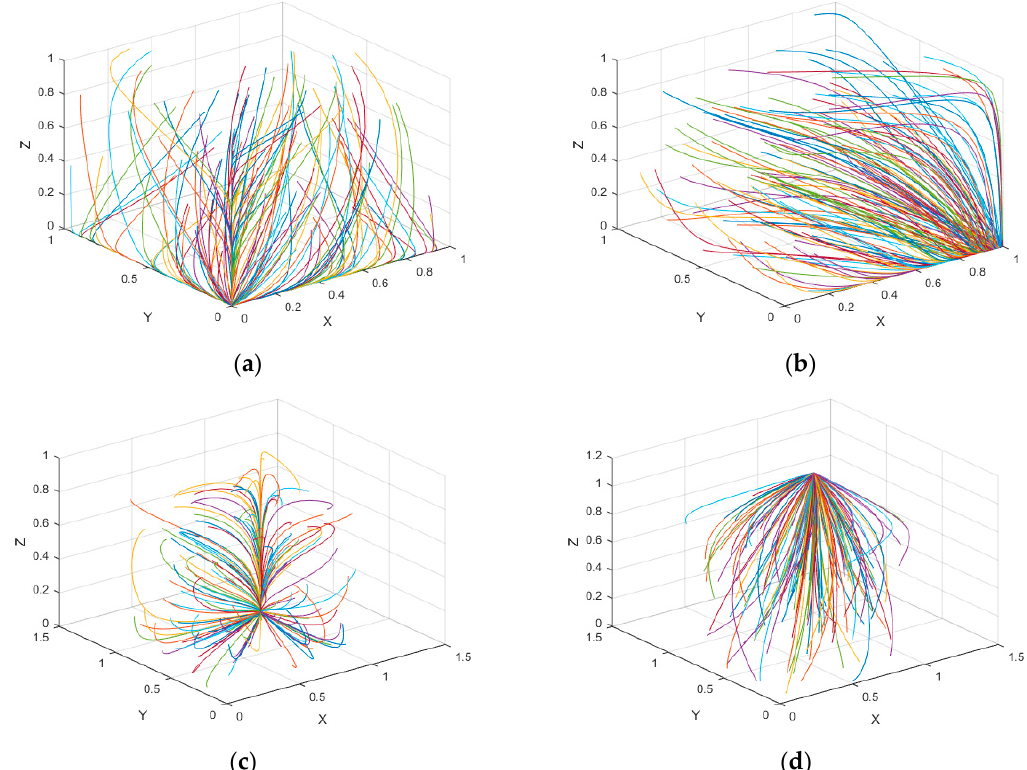
Figure 1. Evolutionary process of each stakeholder. ( a ) E 1 ( 0, 0, 0 ) ( b ) E 2 ( 1, 0, 0 ) ( c ) E 5 ( 1, 1, 0 ) ( d ) E 8 ( 1, 1, 1 ) .